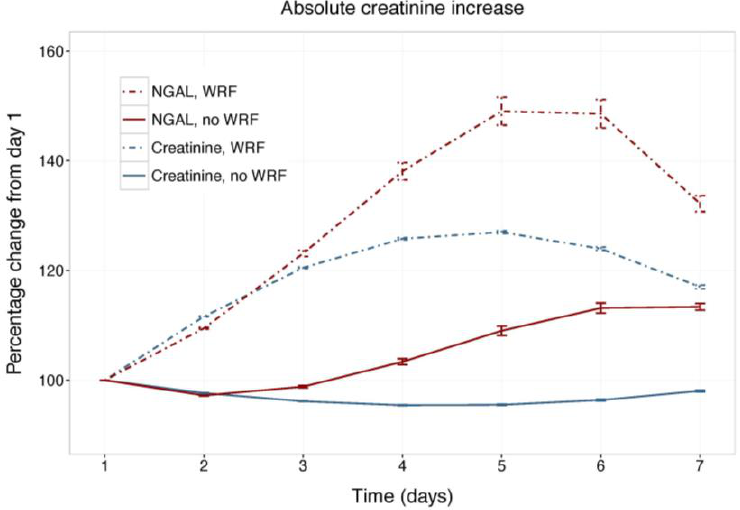
Figure 2. Relative changes in serum creatinine and NGAL. Least square means with 95% confidence intervals. WRF: worsening renal function, defined as creatinine increase of ≥0.3 mg/dL by day 4.